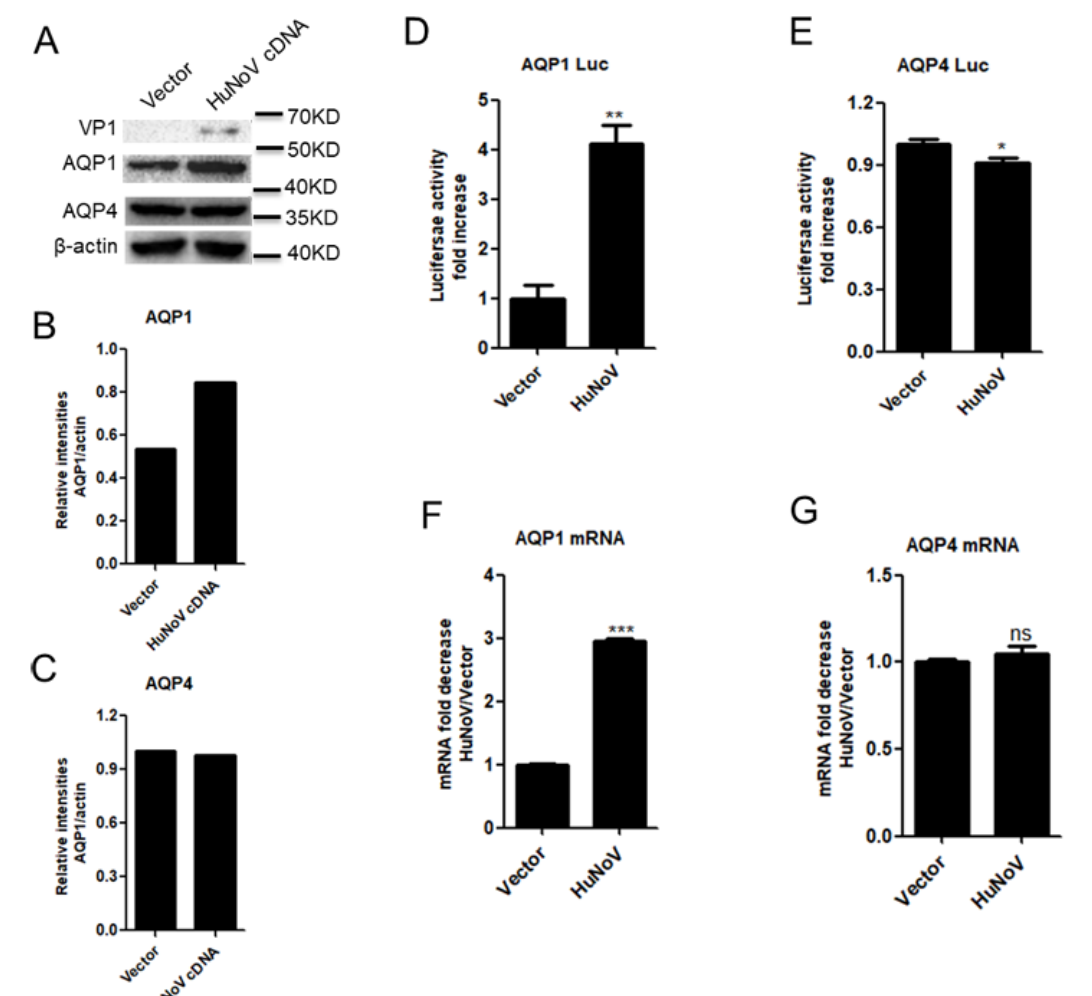
Figure 1. HuNoV transfection promotes AQP1 expression. ( A – C ). HuNoV transfection induced the expression of AQP1 in Caco2 cells. Caco2 cells were transfected with full-length HuNoV cDNA-expressing plasmid or empty vector for 24 h. The protein levels of AQP1, AQP4 and HuNoV VP1 were detected by WB ( A ) and quantified using Image J ( B , C ). ( D , E ). HuNoV promoted the activation of AQP1 promoter. Caco2 cells were co-transfected with empty vector or full-length HuNoV cDNA-expressing plasmid and AQP1-Luc or AQP4-Luc for 24 h. Cells were lysed and detected for the activity of Firefly luciferase. Values for the samples were expressed as a fold increase in the value induced in empty vector-transfected samples. ( F , G ). HuNoV promoted the transcription of AQP1. Caco2 cells were transfected with empty vector or full-length HuNoV cDNA-expressing plasmid for 24 h. Cells were harvested, and total RNA was extracted. The expression of AQP1, AQP4 and GAPDH genes was evaluated by relative real-time quantitative PCR. AQP1 and AQP4 mRNA copies were normalized using GAPDH and expressed as fold increase in the value for the empty vector ( F , G ). Data shown are mean ± S.D. of three independent experiments with each condition performed in triplicate. One representative experiment out of three is shown. * p < 0.05, ** p < 0.01, *** p < 0.001, ns, not significantly.